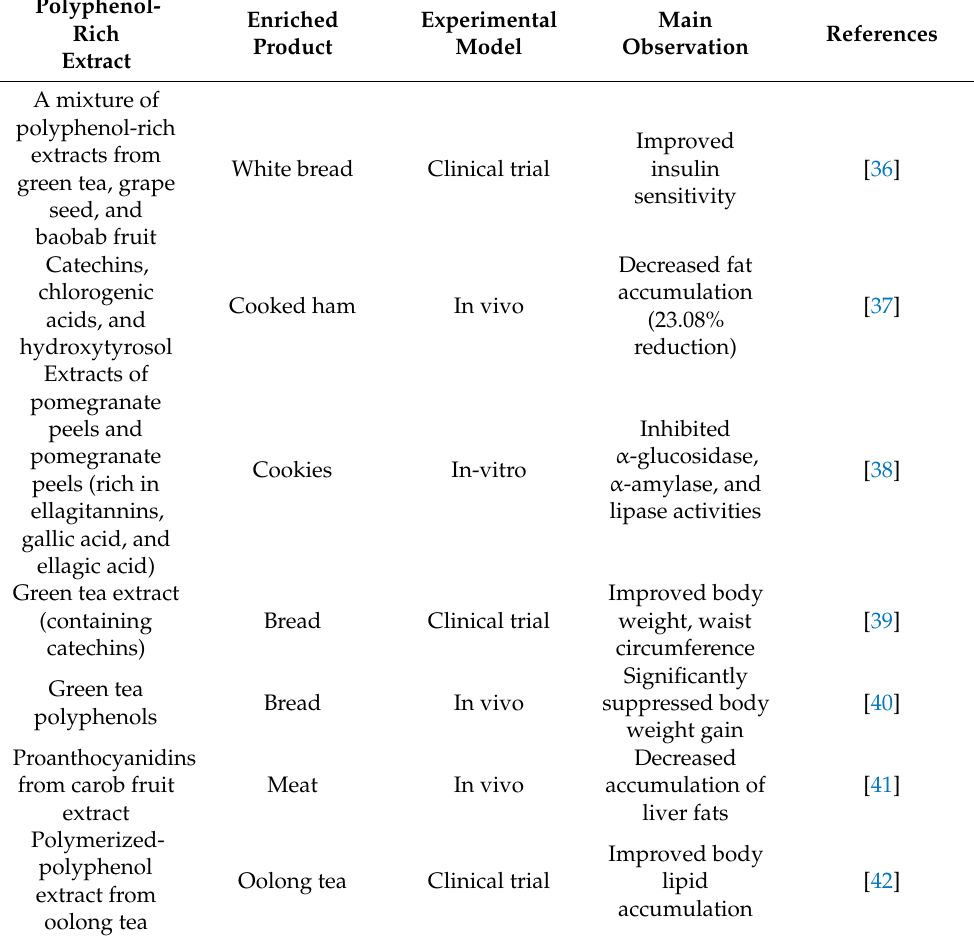
Table 2. Polyphenol-enriched food products targeting